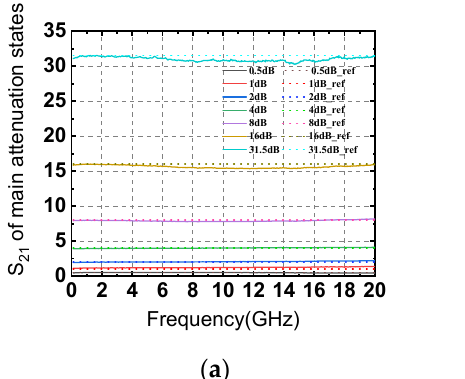
Figure 8. ( a ) Measurement results of the S21 in the main states. ( b ) The relative phase difference curve of the main states.